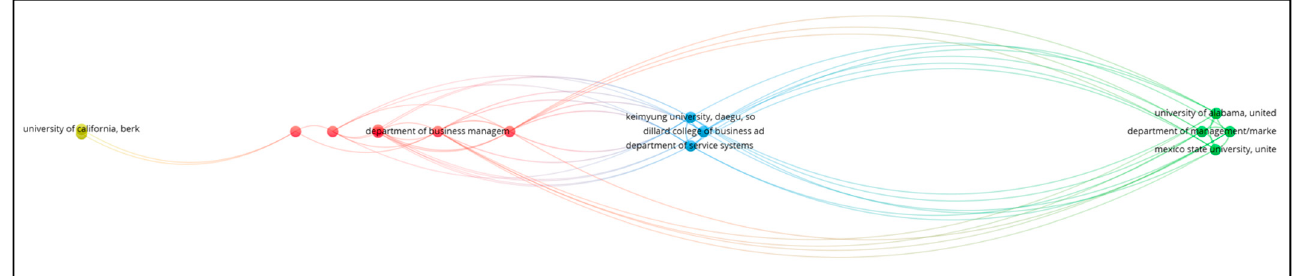
Figure 5. Cluster distribution of organizations publishing a document with at least 20 citations. Note: made by the authors.